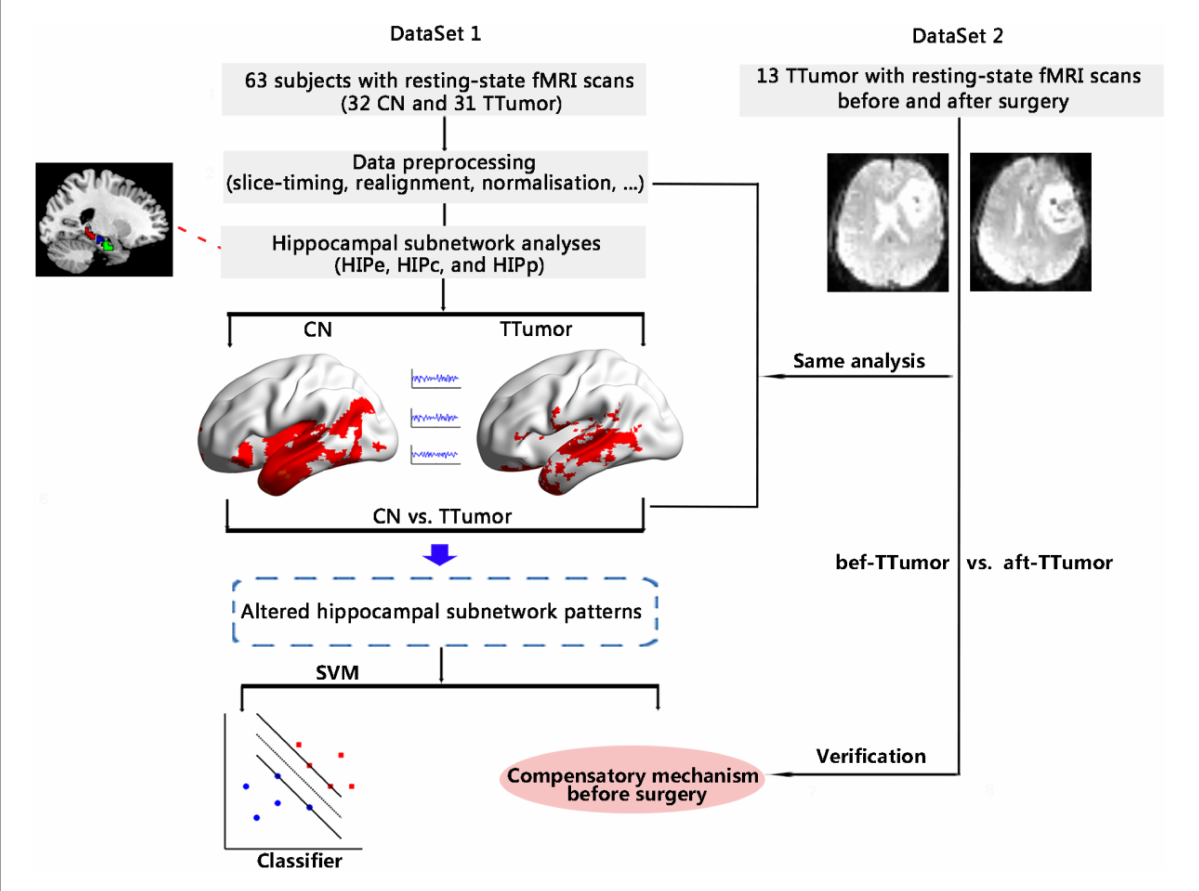
FIGURE1 Schematic of the data analysis pipeline. Firstly, we measured functional connectivity (FC) within hippocampal subnetworks to identify any altered hippocampal subnetwork patterns in 32 CN and 31 TTumor subjects from the first cohort, as well as to identify preoperative compensatory brain areas. Secondly, we further applied a pattern classification approach (SVM) to evaluate whether altered hippocampal subnetwork patterns were able to distinguish TTumor from CN subjects. Finally, to test the stability of brain compensation mechanisms in preoperative TTumor glioma patients, we compared abnormal patterns of the hippocampal subnetwork before and after surgery in the second cohort. CN, healthy controls; TTumor, patients with temporal tumor (glioma); HIPe, hippocampal emotional region; HIPc, hippocampal cognitive region; HIPp, hippocampal perceptual region; fMRI, functional magnetic resonance imaging; SVM, support vector machine; bef-TTumor, patients with temporal tumor (glioma) before surgery; aft-TTumor, patients with temporal tumor (glioma) after